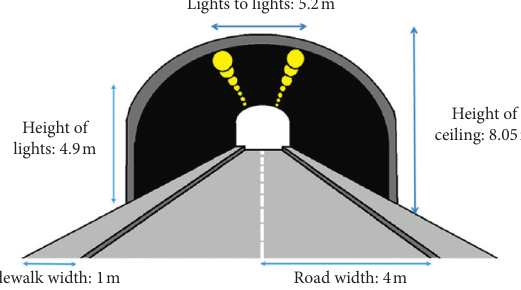
Figure 2: The configuration of the trial tunnel